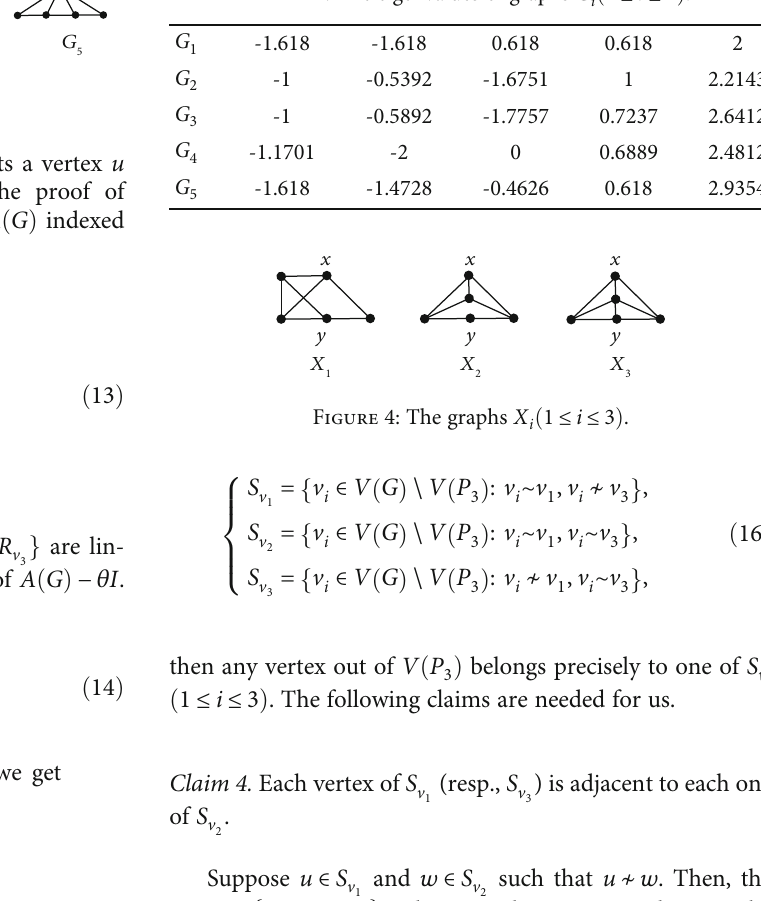
Table 2: The eigenvalues of graphs G